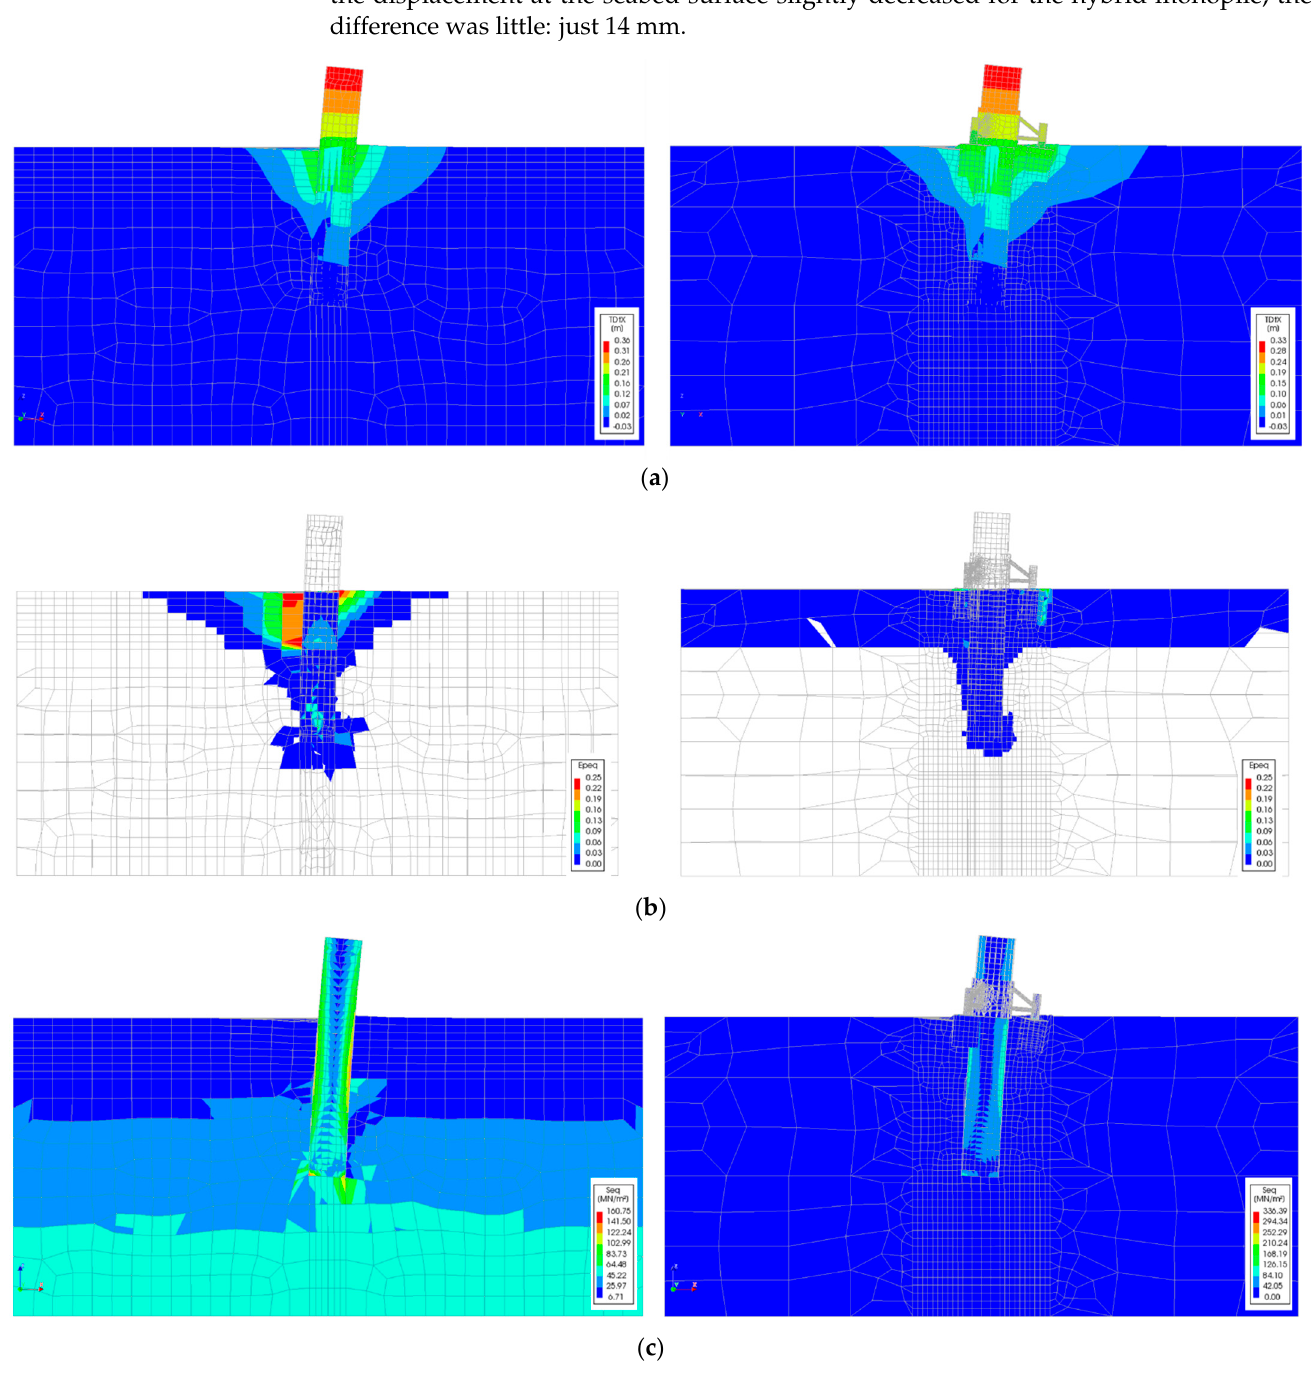
Figure 14. Comparison with results of monopile and hybrid monopile for case A: ( a ) lateral displacement; ( b ) equivalent plastic strain; ( c ) von Mises equivalent stress.